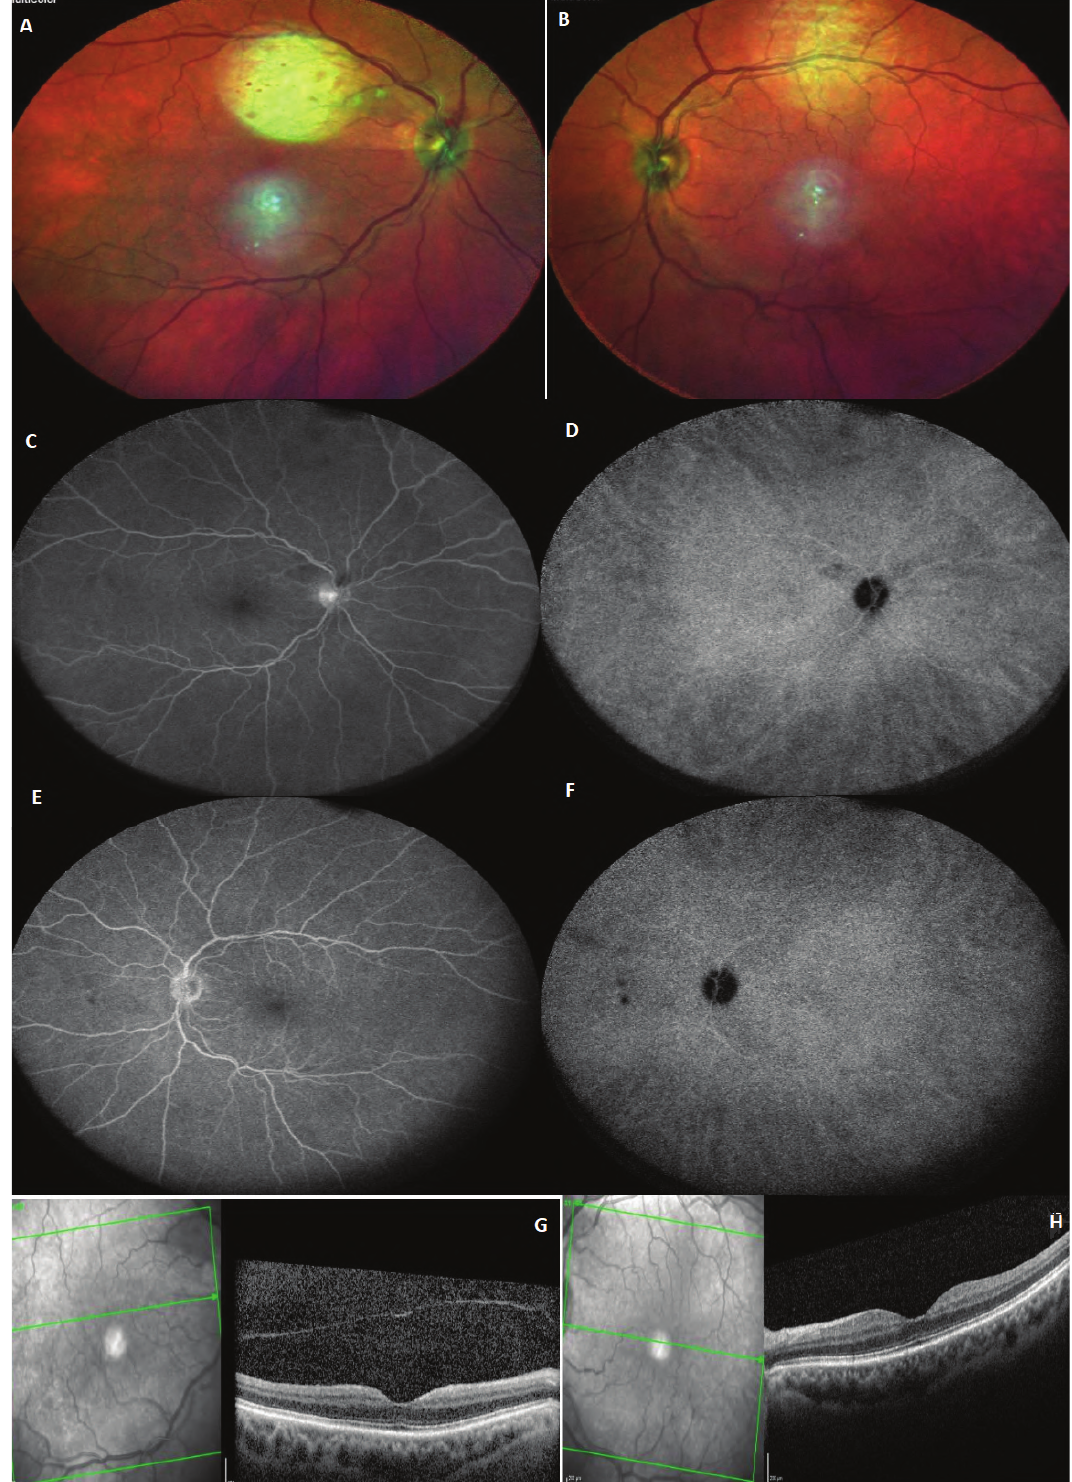
Figure 1. A and B are multicolored images of the right and left eyes, respectively, which illustrate generalized disc pallor in the right optic nerve head and inferior pallor in the left optic nerve head. C and D are the green reflectance images of the right and left eyes, respectively, which demonstrate generalized nerve fiber loss in the right eye and inferior nerve fiber layer loss in the left eye. E and F are the late phase of fluorescein angiography of the right and left eyes, respectively, and G and H are macular optical coherence tomography of the right and left eyes, respectively. These appear